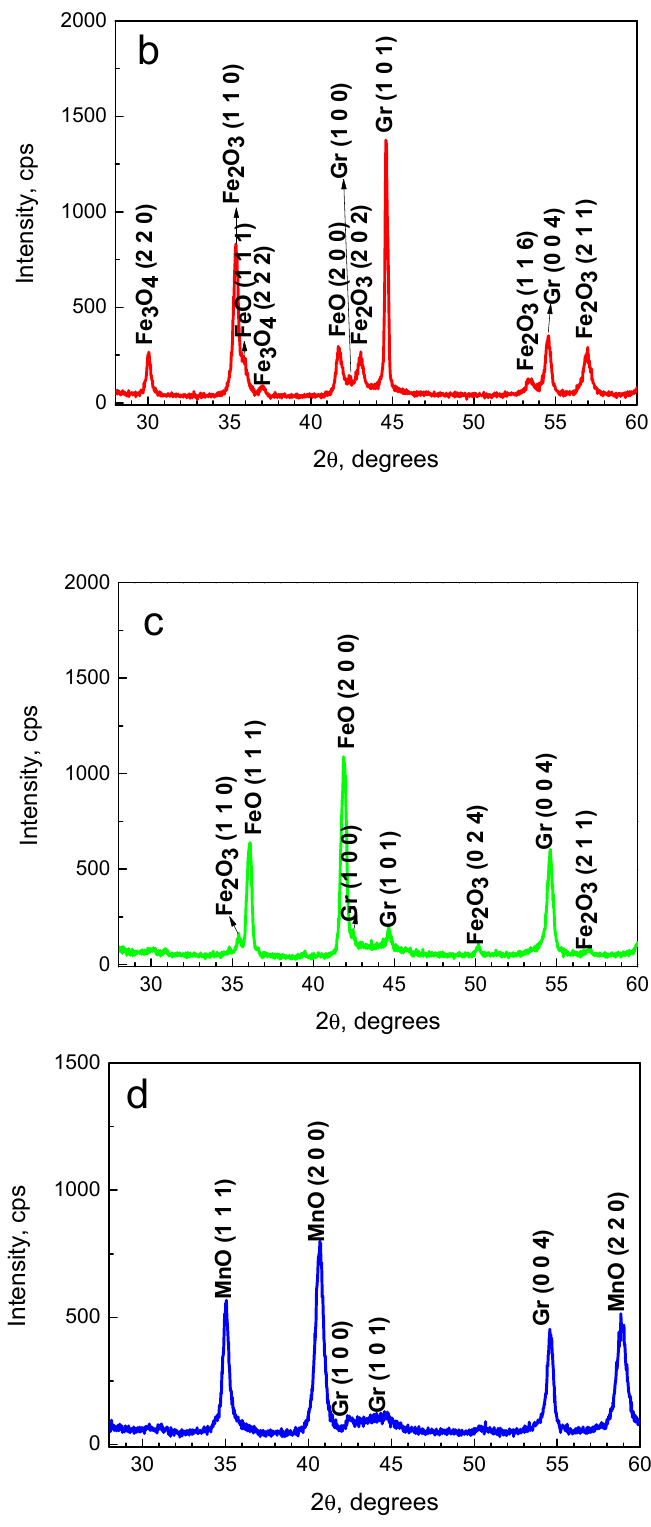
Figure 1. XRD spectra of the produced composite materials: ( a ) non-modified graphite; ( b ) Gr–Fe 2 O 3 ; ( c ) Gr–Fe 3 O 4 ; ( d ) Gr–Mn 3 O 4 . In addition to XRD analyses, the fabricated materials were also examined by scanning electron microscopy, and their surface morphology was compared to that of the non-modified graphite samples (Figure 2). The SEM-images of all modified samples showed inclusions of metal oxides, which changed the morphology of the pure graphite from a typical flake-like structure with graphite micro-sheets to a grooved surface with uneven located metal oxides particles. The samples containing Fe-oxides displayed similar patterns because of their similar composition, as established by XRD. It is supposed that the observed spherical forms of the particles were due to a reduction in surface tension, as described by Jung et al. [15], while the agglomerated formations were associated with particle growth [16]. Although similarities in particle shapes and sizes were observed, the comparison of the SEM images presented in Figure 2b,c revealed a higher loading of metal oxide particles, resulting in more developed surface morphology of the Gr–Fe 2 O 3 sample. Given the structural polymorphs of manganese oxides [17], the observed MnO nanoflakes masked and overlapped the supporting graphite structure and were more difficult to be distinguished on the SEM.